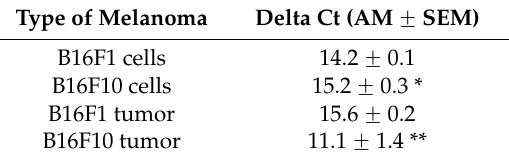
Table 1. The expression of endoglin in melanoma cells and tumors represented as mean delta Ct ˘ SEM (threshold cycle) values. Delta Ct represents the difference between the Ct of endoglin and the Ct of the reference gene.